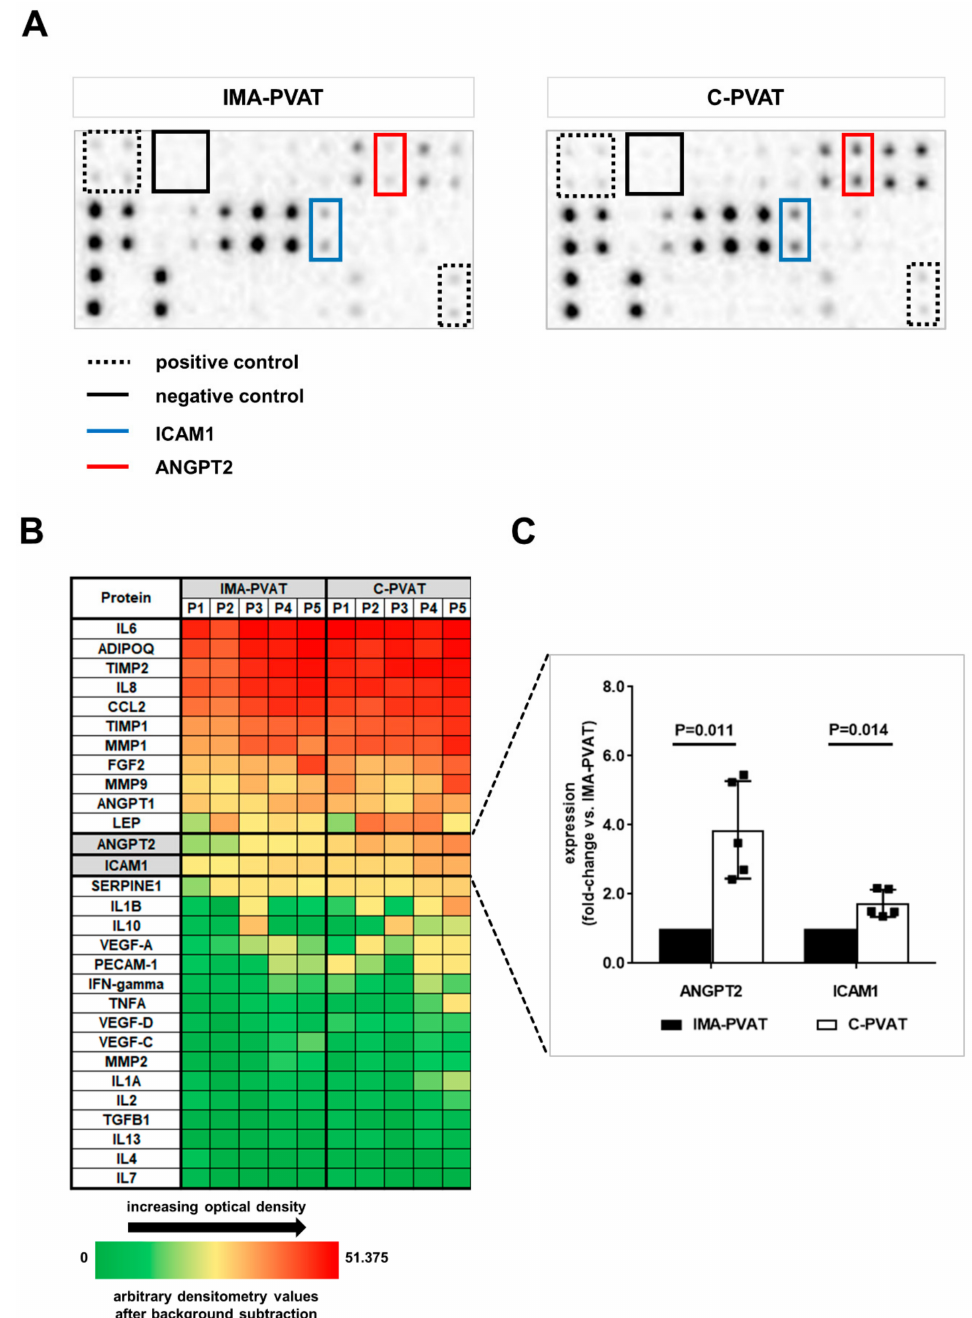
Figure 4. Protein array analysis of factors potentially involved in perivascular lymphangiogenesis. ( A ) Representative chemiluminescence detection images of a protein membrane array in IMA-PVAT- and C-PVAT-derived conditioned medium from one patient with CAD. A commercially available membrane-based antibody protein array was used. Each vertical pair of dots represents one